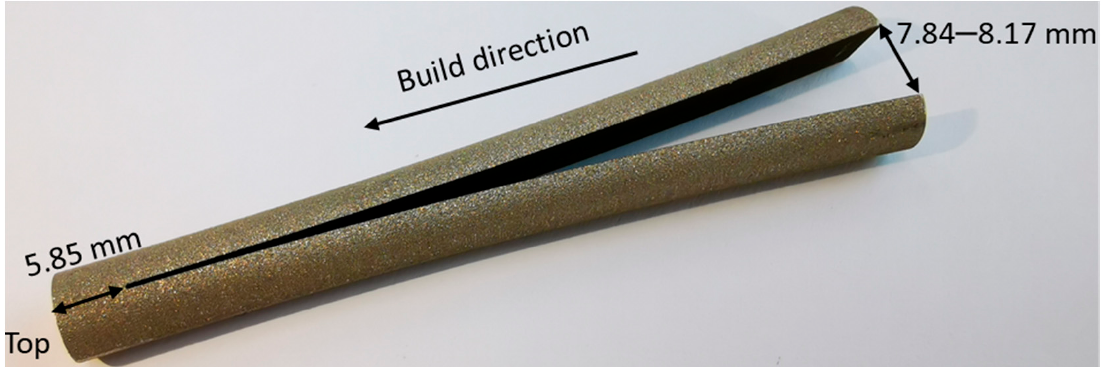
Figure 5. Validation experiment with cut of vertically built cylindrical